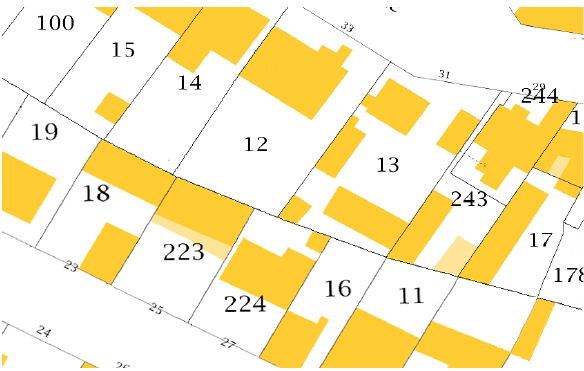
Figure 8: Cadastre ground truth priorily conflated building